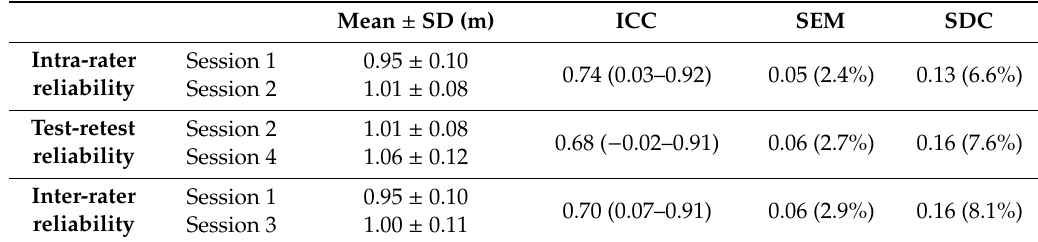
Table 9. Results for gait cycle length.